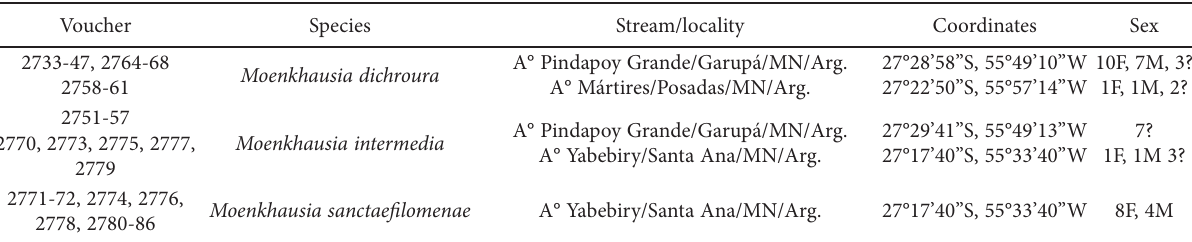
Table 1. Specimens of Moenkhausia collected. F: females, M: males, ?: undetermined sex. Voucher